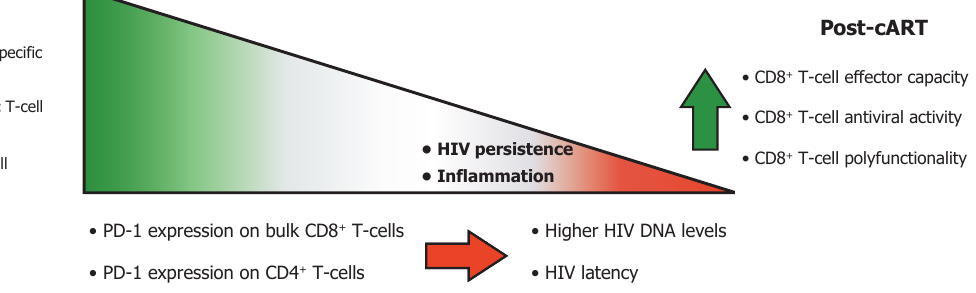
Figure 6: Summary of the associations between the function and phenotype of CD4+ and CD8+ T-cells pre-cART with the immune function, viral markers of HIV persistence and inflammation levels post-